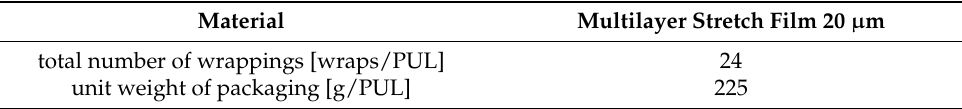
Table 6. Parameters of cargo application with non-standard film.